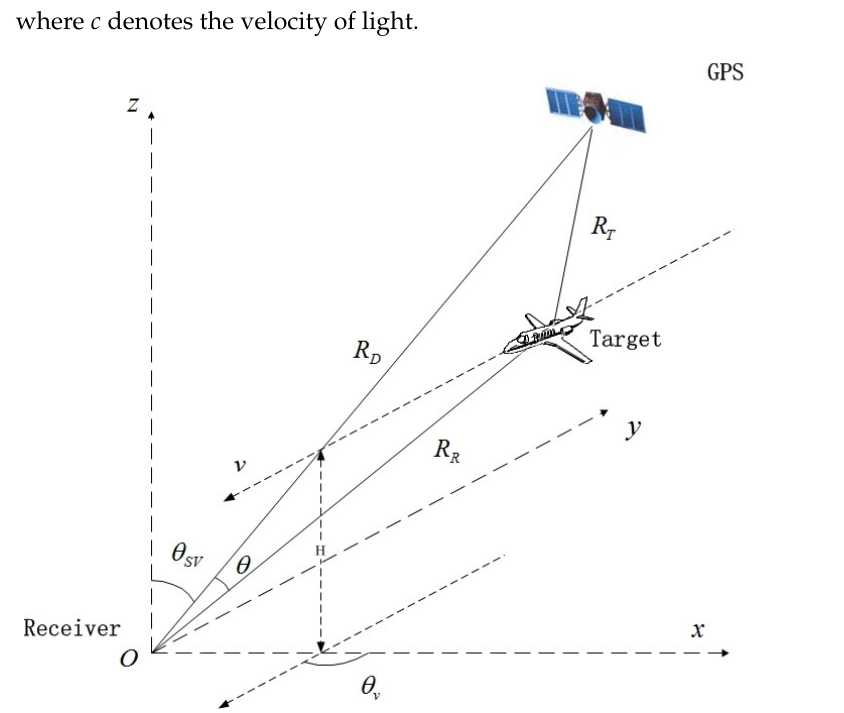
Figure 2. Geometric model of forward scatter